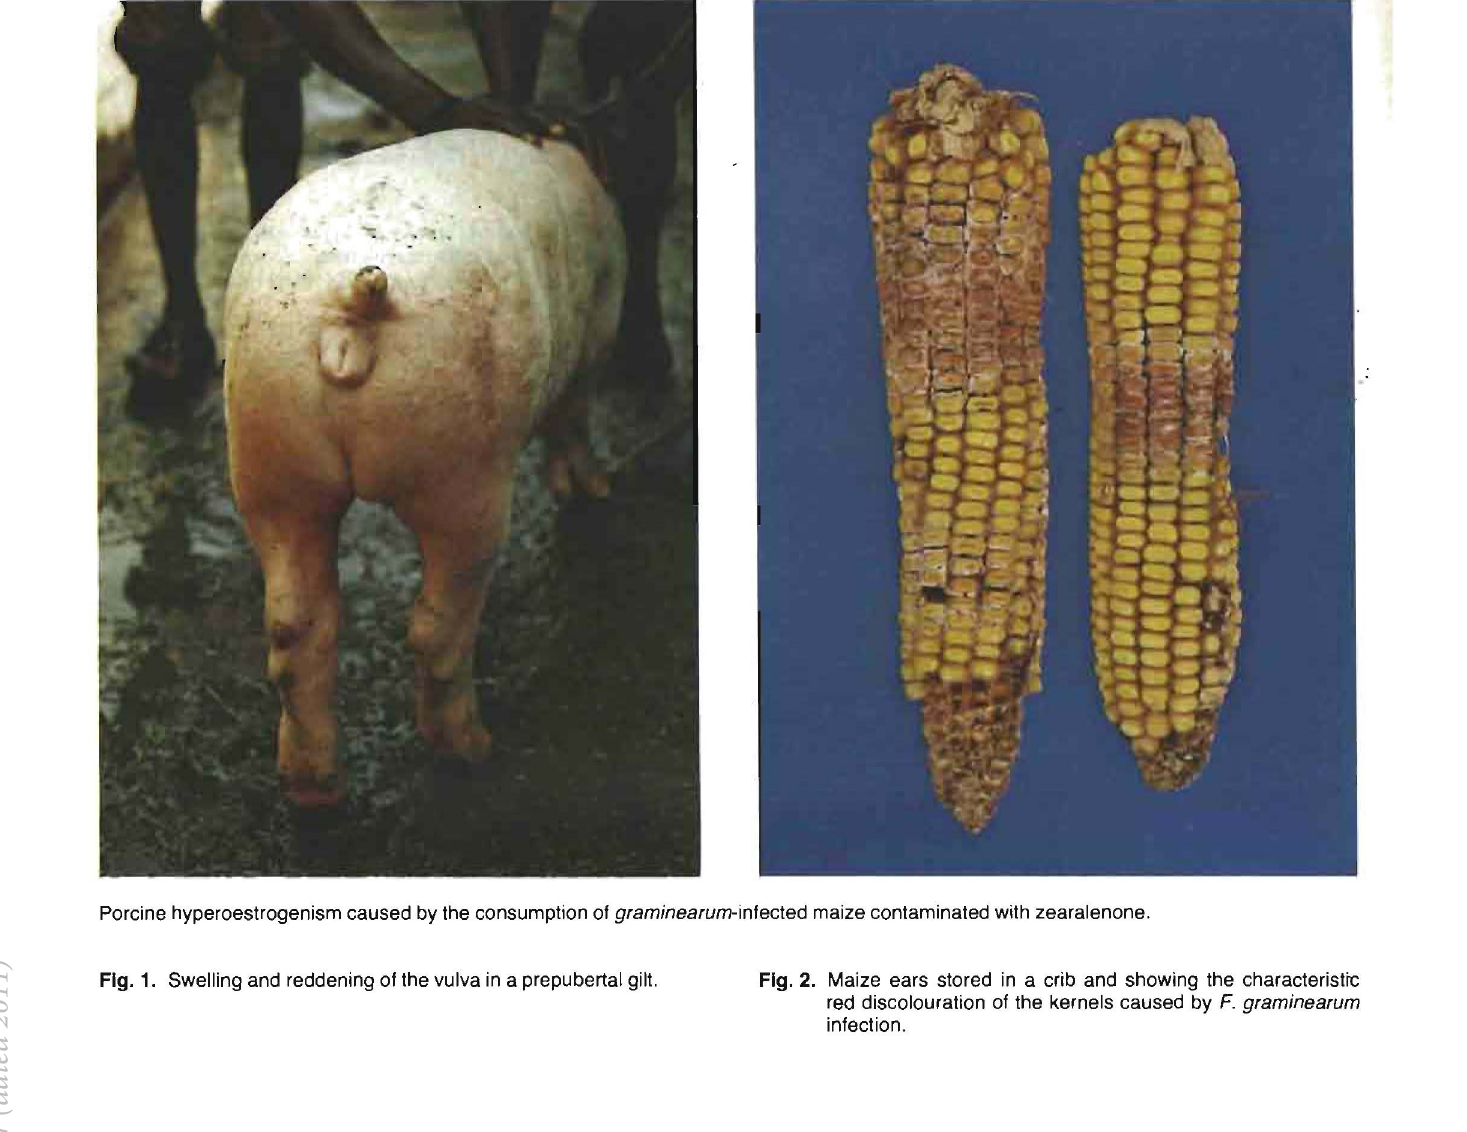
red discolouration of the kernels caused by F. graminearum